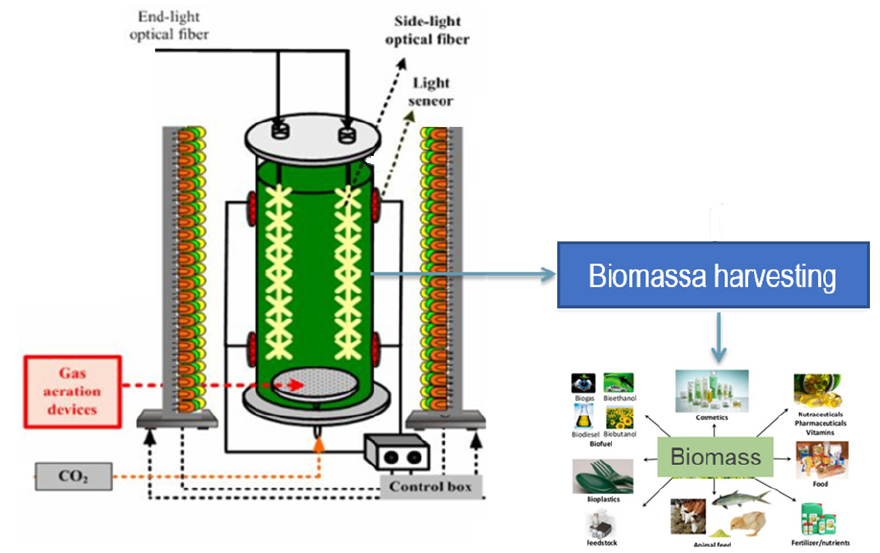
Figure 1. Experimental set-up schematization.